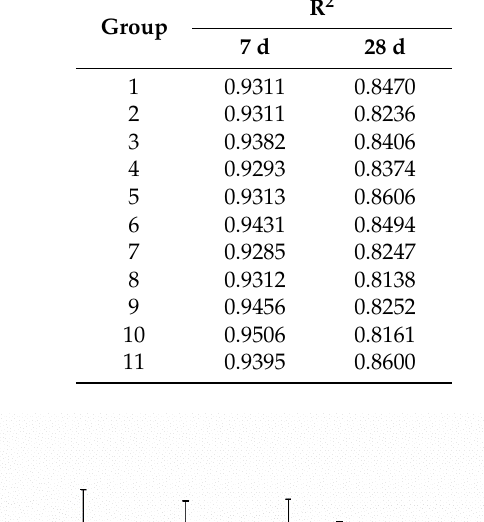
Table 3. The R 2 between tested and fitted compressive strength of concrete at age of 7 days and 28 days.